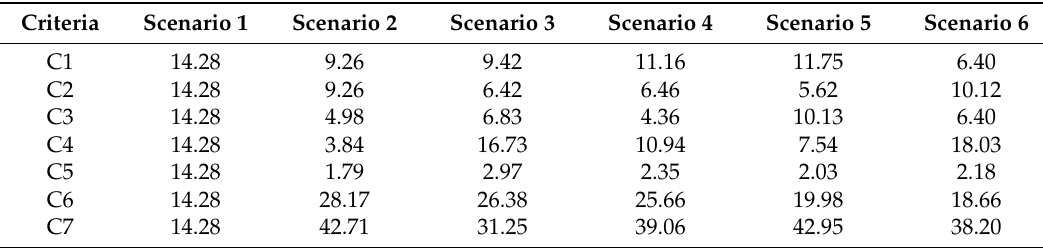
Table 11. Relative non-fuzzy normalized weights ( w ) for each criteria